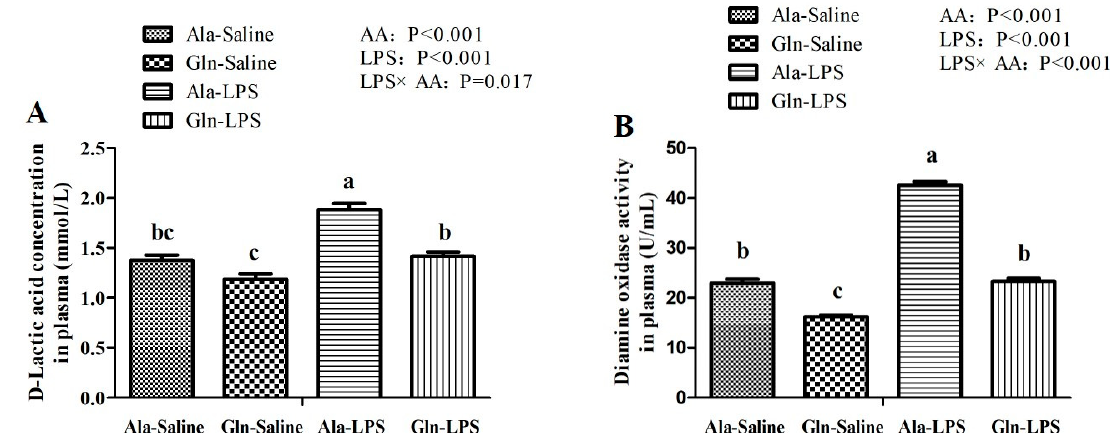
Figure 2. Effects of Gln supplementation on D-lactic acid concentration ( A ) and diamine oxidase activity ( B ) in plasma of broilers following treatment with LPS or saline. Values are means ± SEM n = 10 (10 chicken per treatment). The significant difference is indicated by p < 0.05.